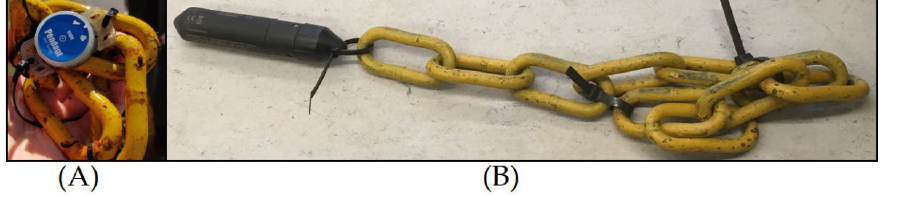
Figure 2 . ( A ) HOBO Pendant MX2201 [ ℃ ] and ( B ) HOBO Water Level Data logger [kPa & °C] .